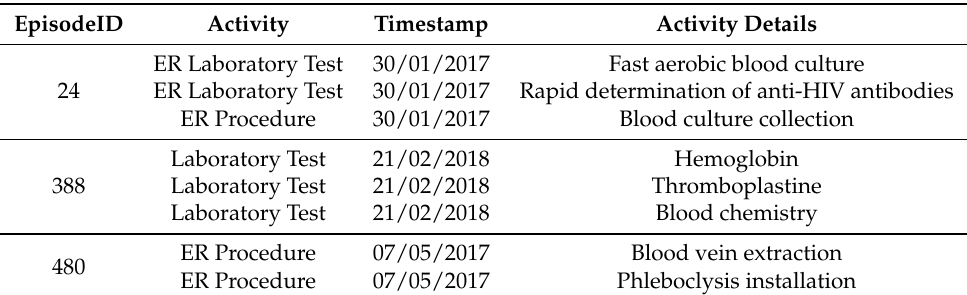
Table 2. Example of the an event log at activity